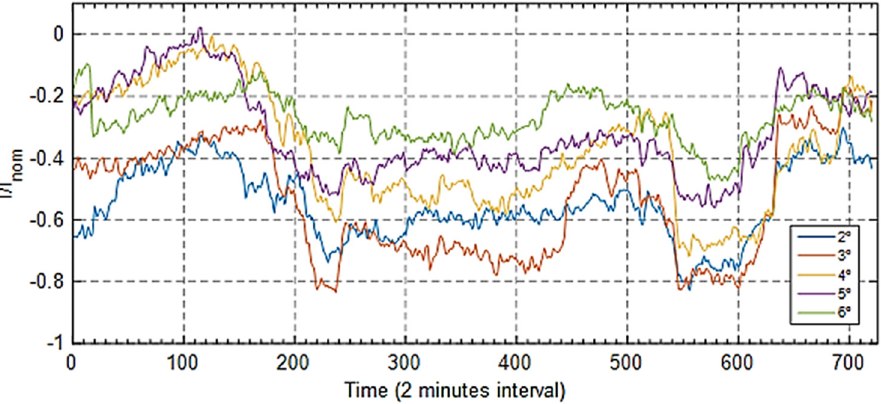
Figure 22. Evolution of apparent power S1 (“MVA”).